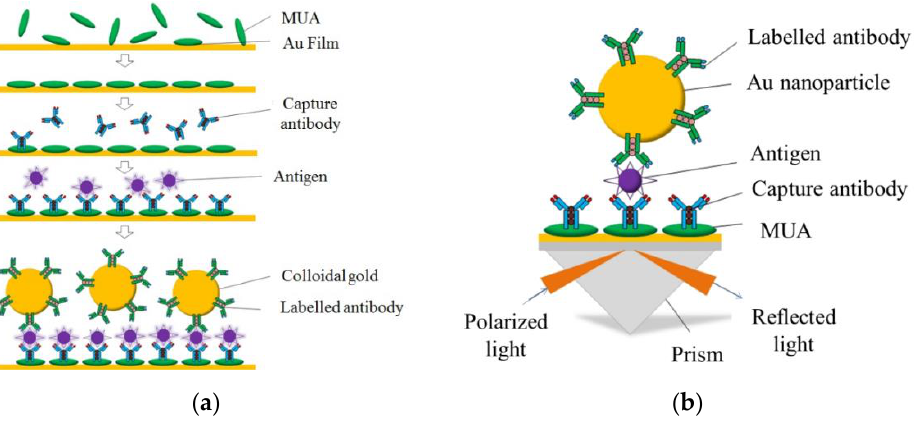
Figure 2. ( a ) Schematic of the oriented immobilization of the AuNPs-antibody onto the assembled SPR sandwich immunosensor chip. ( b ) Schematic of the SPR sandwich immunosensor chip with the AuNPs-monoantibody bioconjugate for signal amplification.